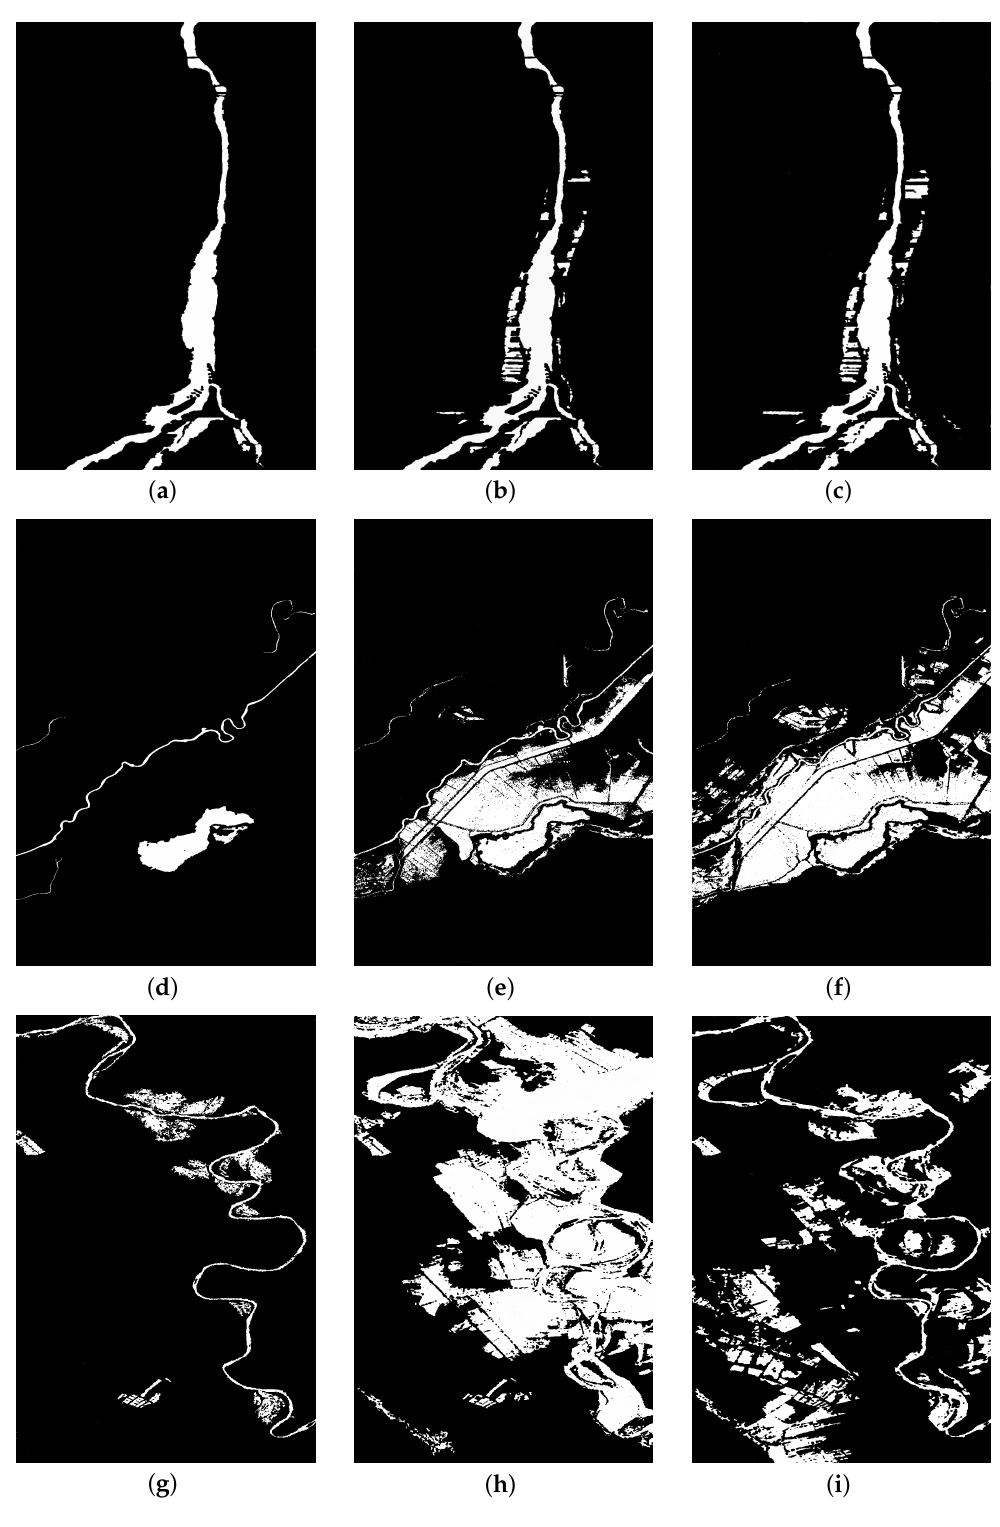
Figure 9. Binary images used as a reference in the three study areas. ( a ) Pre-disaster image (site 1); ( b ) Post-disaster image t 1 (site 1); ( c ) Post-disaster image t 2 (site 1); ( d ) Pre-disaster image (site 2); ( e ) Post-disaster image t 1 (site 2); ( f ) Post-disaster image t 2 (site 2); ( g ) Pre-disaster image (site 3); ( h ) Post-disaster image t 1 (site 3); ( i ) Post-disaster image t 2 (site